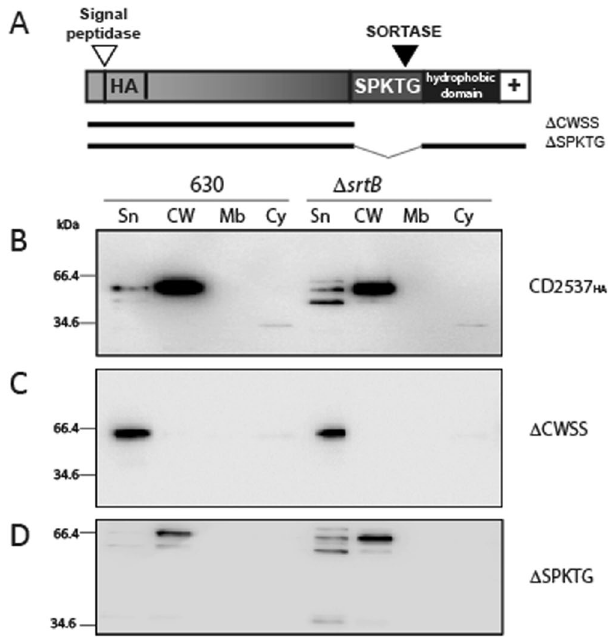
Figure 3. CD2537 cell wall association can occur independently of sortase activity. ( A ) Schematic of putative sortase substrate CD2537 HA protein and predicted cleavage sites with derivatives indicated by bars. Wild type 630 and the Δ srtB mutant carrying pJKP064 expressing full length CD2537 HA ( B ), and derivatives lacking the cell wall sorting signal (pJKP071; Δ CWSS) ( C ), or the SPKTG sorting motif (pJKP072; Δ SPKTG) ( D ) were fractionated into supernatant (Sn), cell wall (CW), membrane (Mb) and cytoplasm (Cy) compartments. Proteins were visualised by western blot with anti-HA tag antibody. Western blots were cropped for clarity; uncropped images can be found in Supplementary Fig.